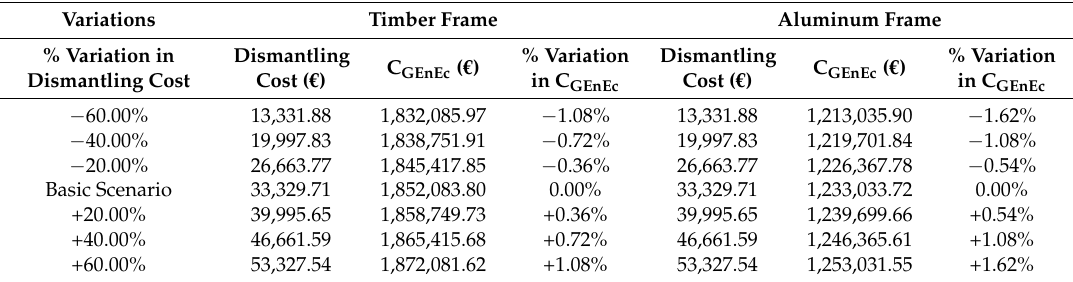
Table 12. Sensitivity analysis with decreased/increased dismantling